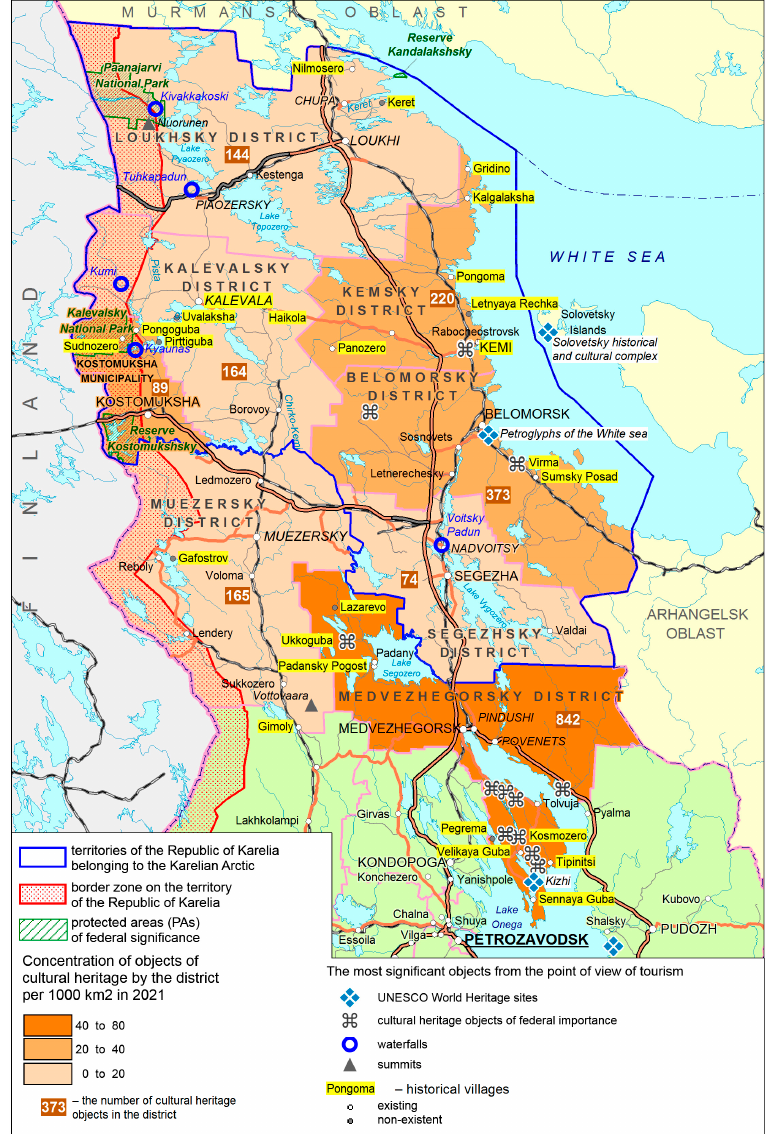
Figure 2. Resources for the development of tourism in the Karelian Arctic and regions economically connected with it.